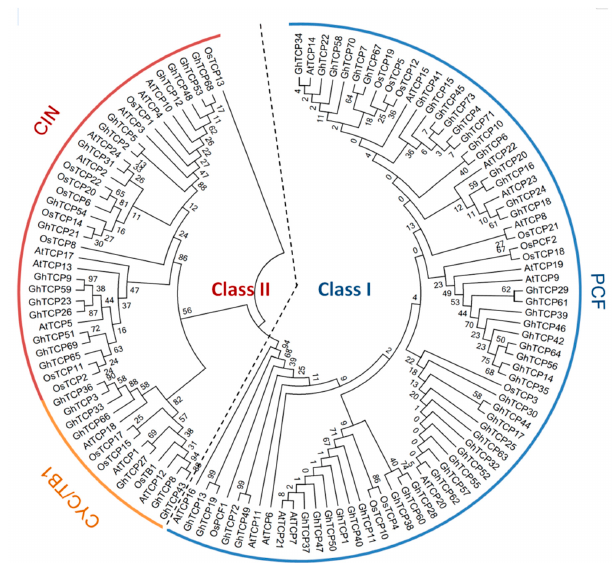
Figure 1. Phylogenetic analysis of TCP proteins from G. hirsutum , Arabidopsis , and rice. The deduced full-length amino acid sequences were aligned using ClustalX 2.0 and the phylogenetic tree was constructed using MEGA 6.0 by the Neighbor-Joining (NJ) method with 1000 bootstrap replicates. The three subclasses are indicated with different colors.